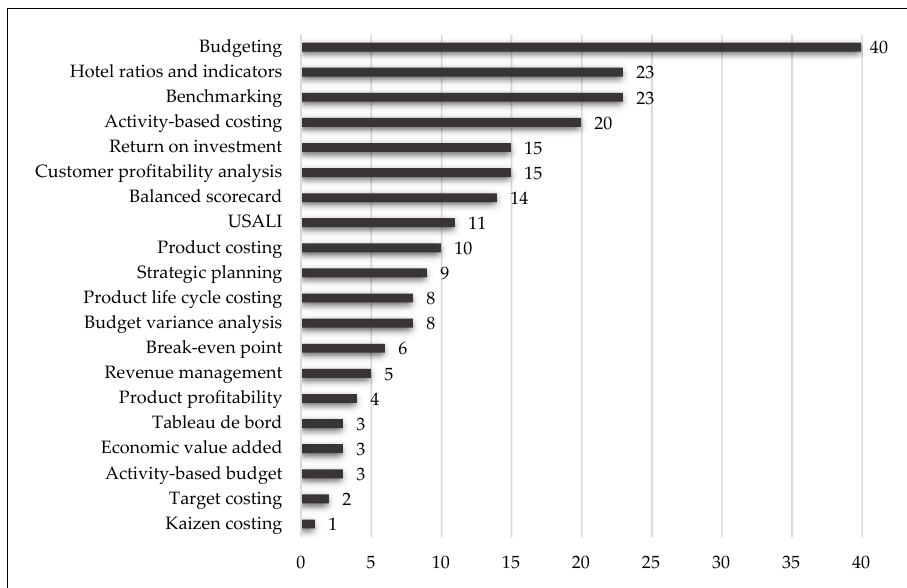
Figure 8. Hospitality management accounting practices.